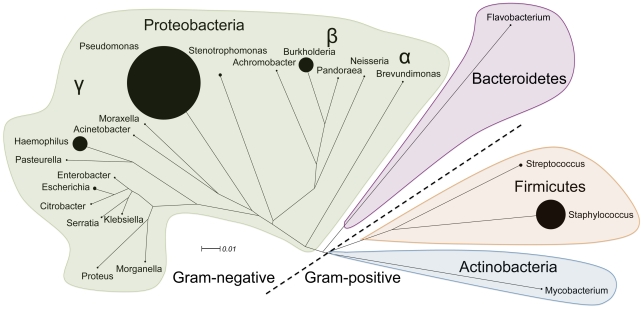
Bacterial genera recovered from CF sputum during 28 years of using conventional cultivation approaches.The proportional abundance of each genus in the culture collection (19 250 isolates) is depicted with solid circles.